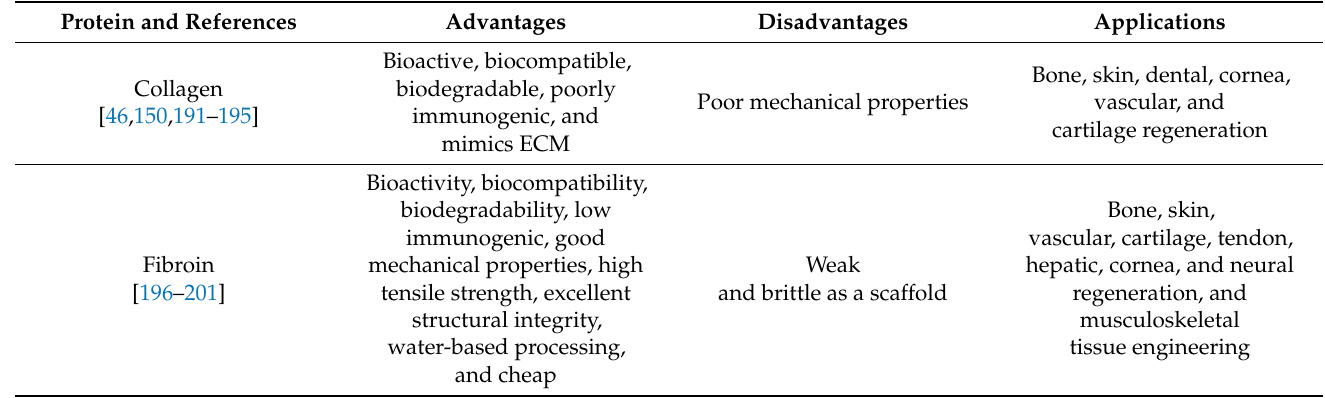
Table 4. Advantages, disadvantages, and applications of proteins in tissue regeneration